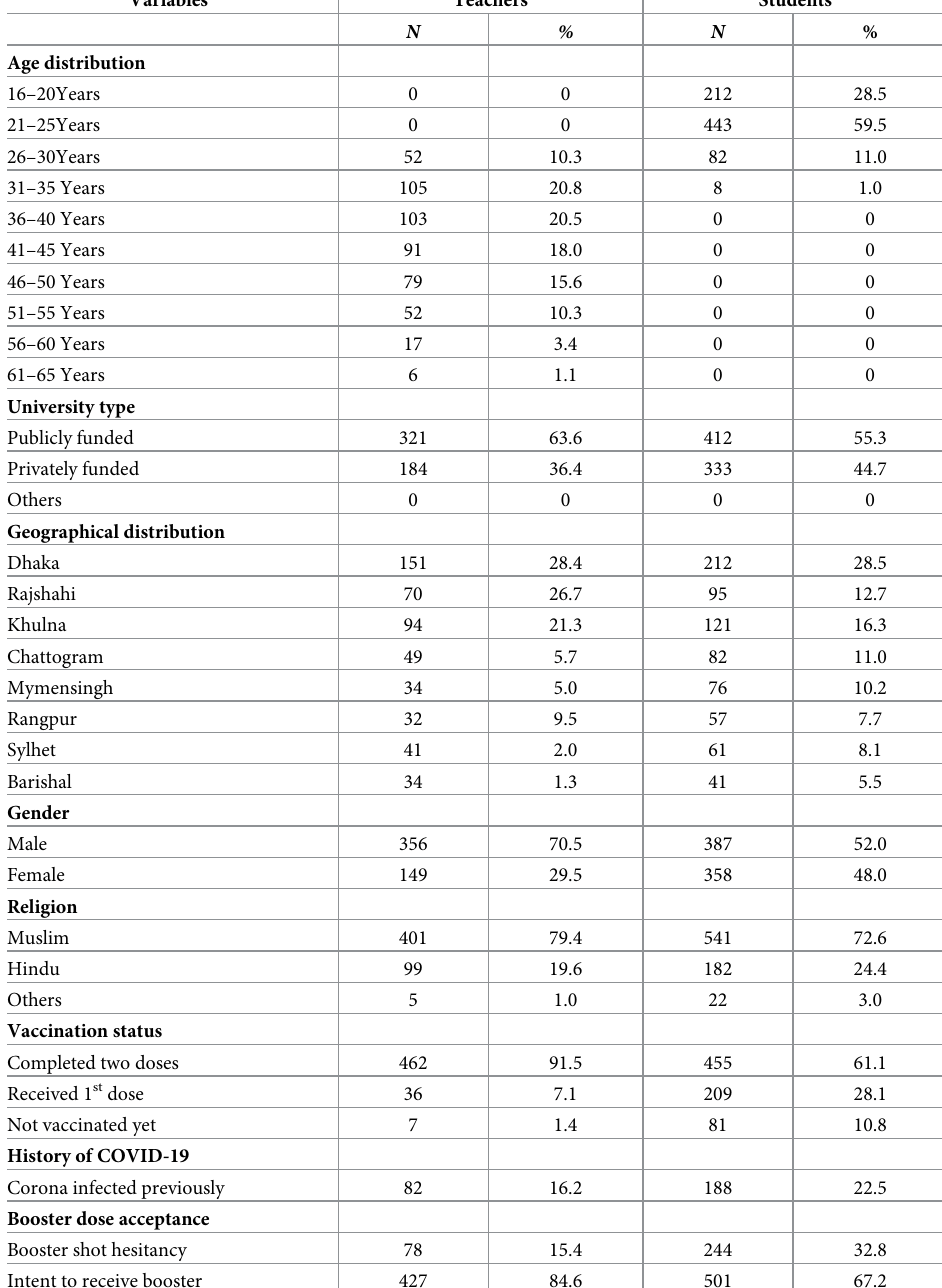
Table 1. Overview of socio-demographic profile of study participants (N = 505